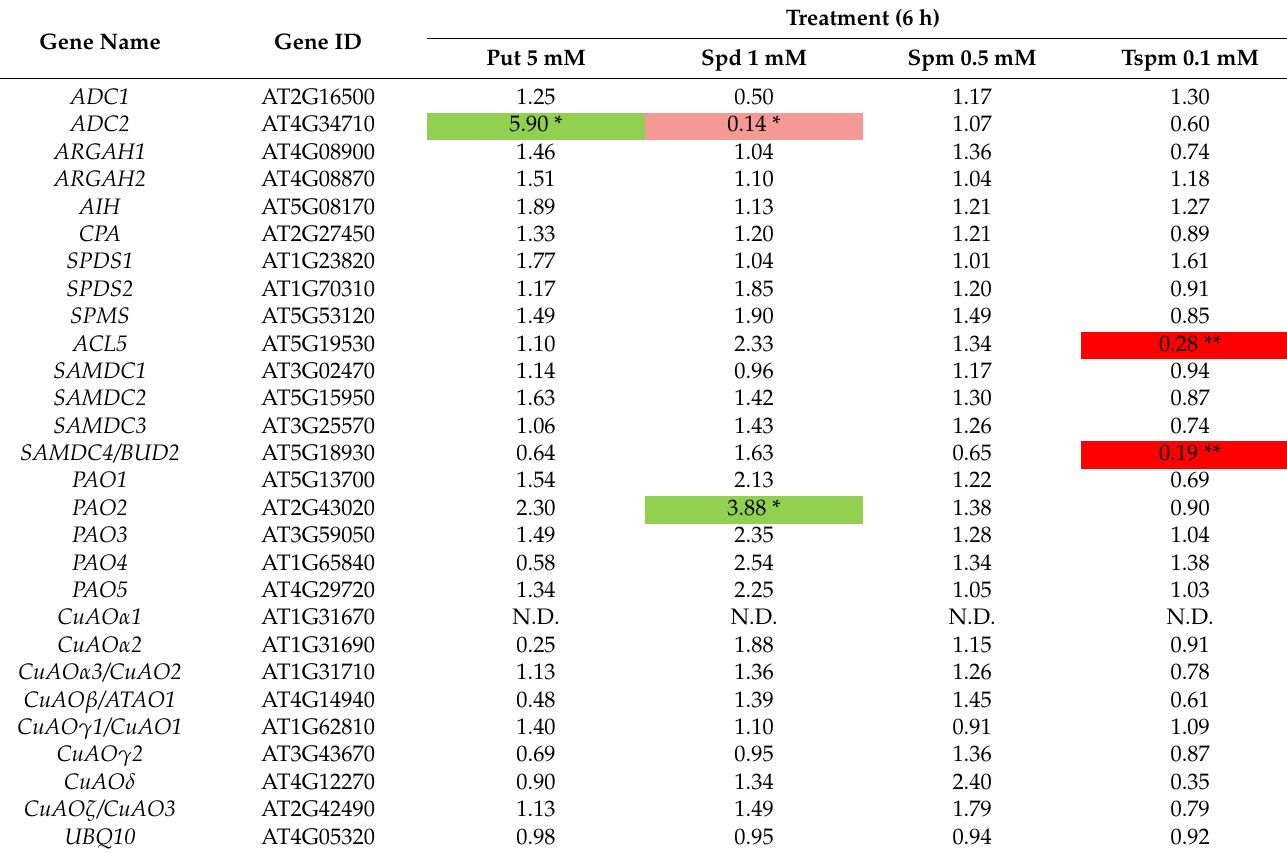
Table 1. Effect of polyamine treatment on polyamine metabolic